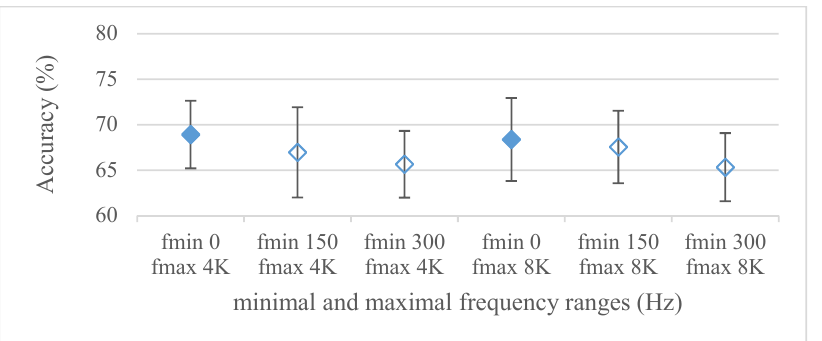
Figure 7. Averaged accuracies and standard deviations as functions of minimal and maximal frequency limits; Fmin {0+, 150, 300 Hz}, Fmax {4, 8 kHz}; and no pre-emphasis. Filled marks show equally performing settings.